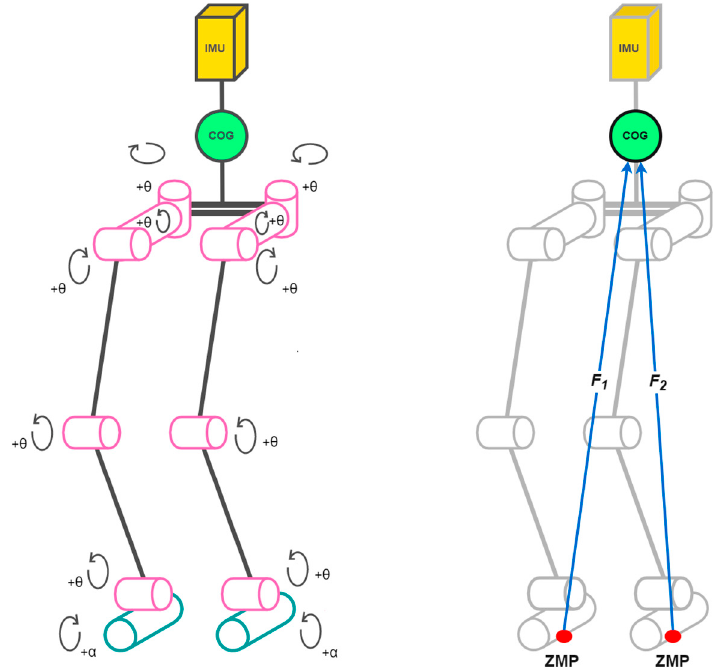
Figure 5. Kinematic model of the robot ( left ), visualization of LIPM and ZMP principles on the kinematic model ( right ).